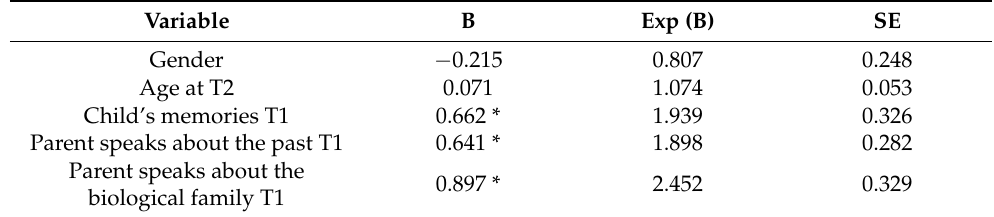
Table 4. Multivariate logistic regression of child’s questions about the past (0 = “yes”; 1 = “no”).